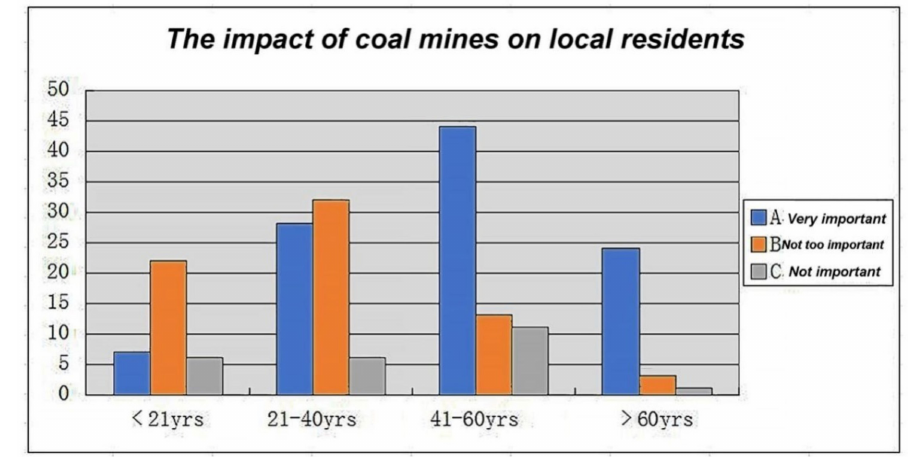
Figure 7. Local residents’ statistics on the importance of coal in their lives.